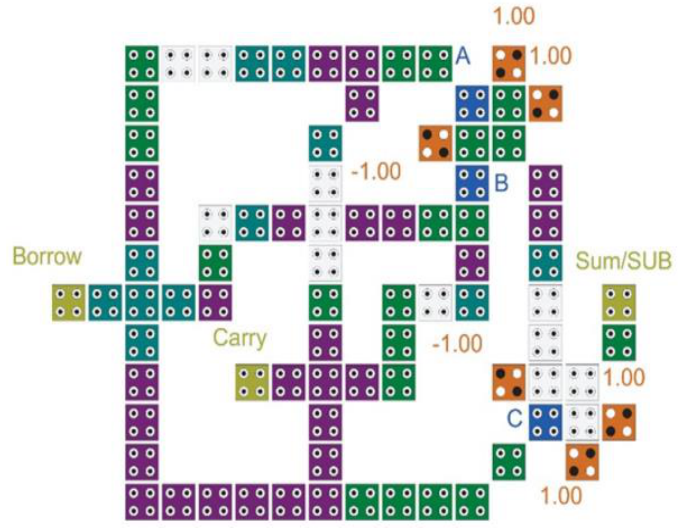
Figure 7. Full Adder/Full Subtractor circuit [14].